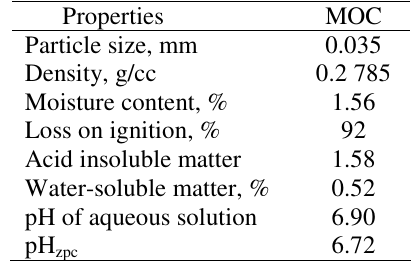
Table 1. Characteristics of the adsorbent.